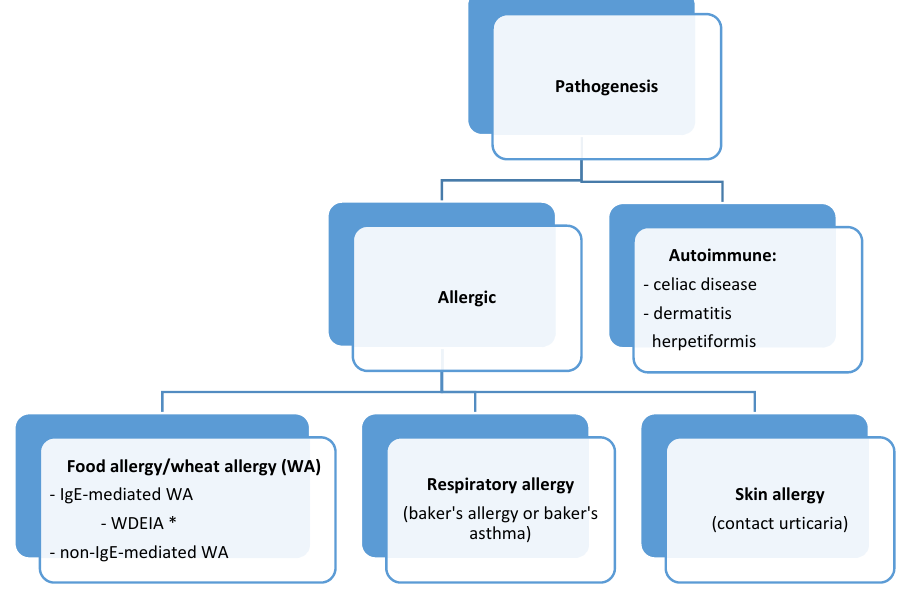
Figure 1. Classification of wheat ‐ related allergic diseases. * WDEIA—wheat ‐ dependent exercise ‐ induced anaphylaxis.